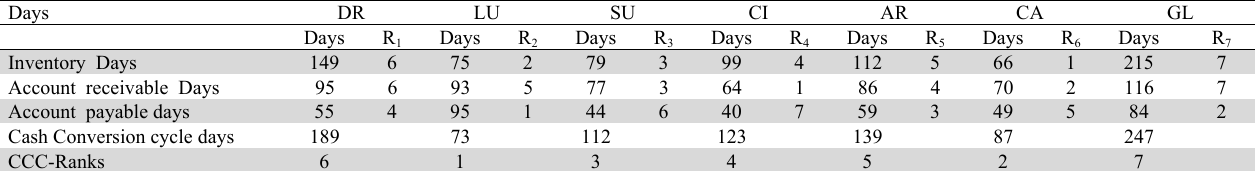
Source: Based on calculation of table 3, 4, and